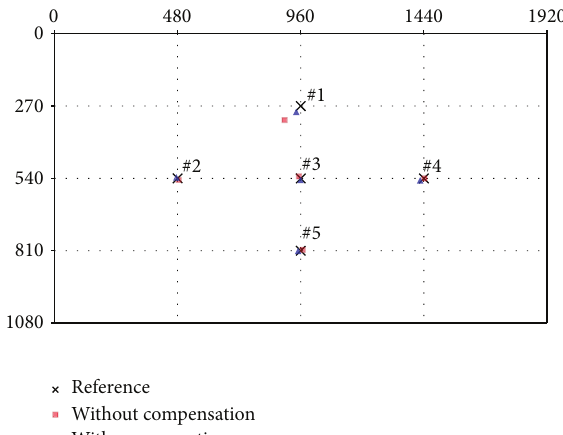
Figure 12: Experimental results of detecting target positions against reference positions [10].